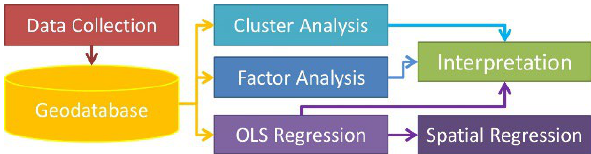
Figure 3. Methodological